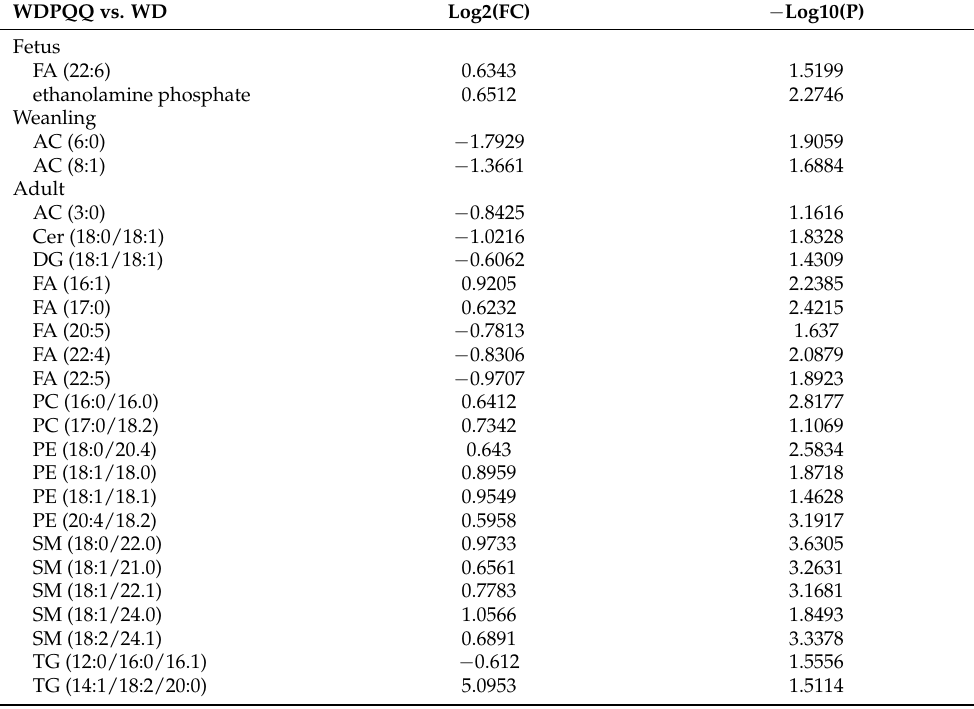
PQQ given only during gestation altered enrichment of more long-chain and VLC FAs and increased abundance of sphingomyelins in adult liver.